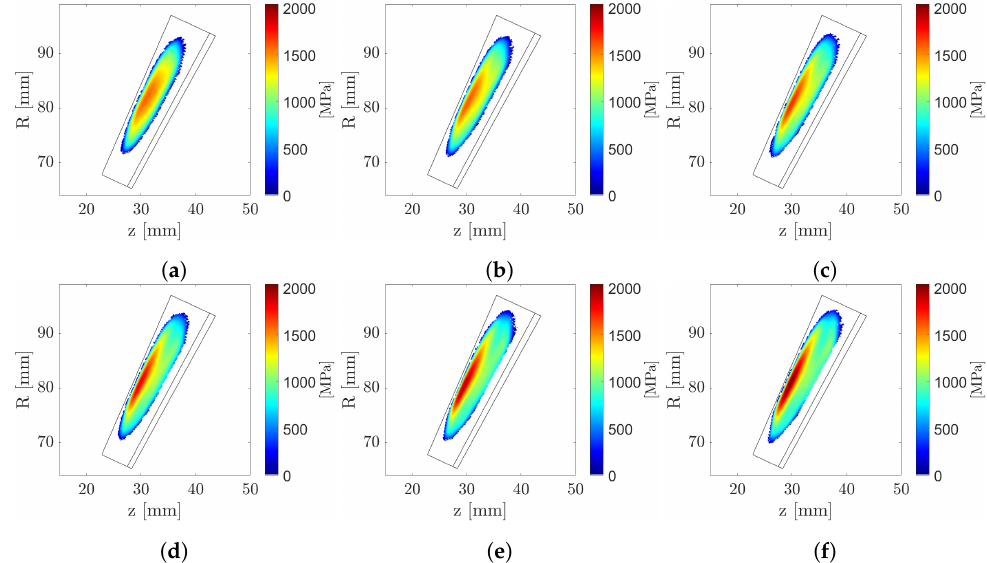
Figure 14. Evolution of the gear contact pattern with a geometry update every 5 Mc. ( a ) 5 Mc.